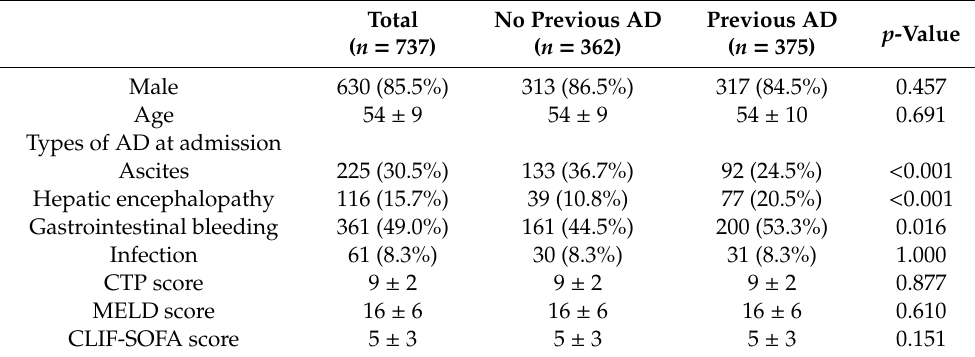
Table 3. Comparison of the characteristics of patients with and without previous acute decompensation (AD) among groups 1 &